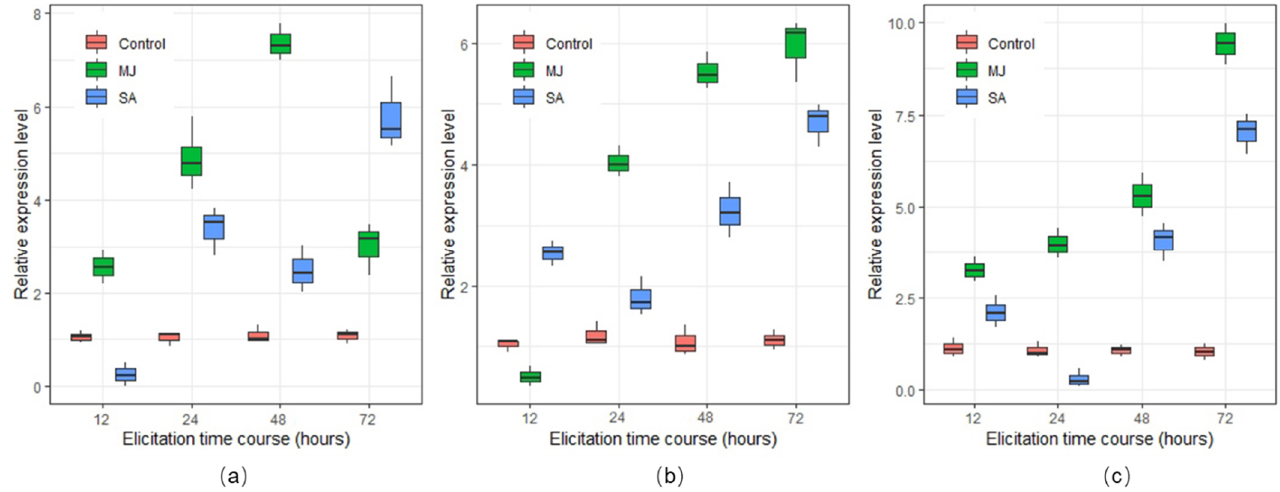
Figure 5. Effects of MJ and SA elicitation, at different time courses, on the expression of nominated benzophenanthridine alkaloids genes in cultured Greater Celandine cells. ( a ) TNMT, ( b ) STS , and ( c ) CFS . Non-elicited cells were used as control. The concentration of MJ and SA was 100 µM . EF1- ɑ was used as an internal control to normalize variation in the amount of cDNA template. Each data point represents the mean value of three biological and three technical replications.